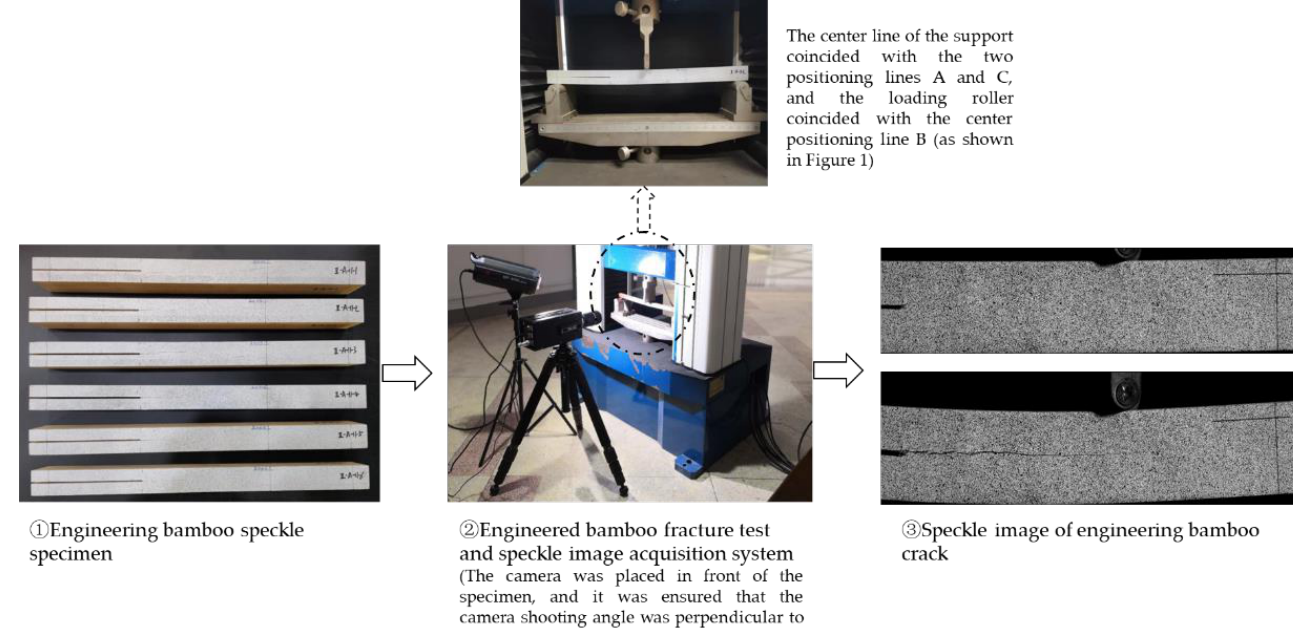
Table 1. Equipment performance parameters and experimental parameters.